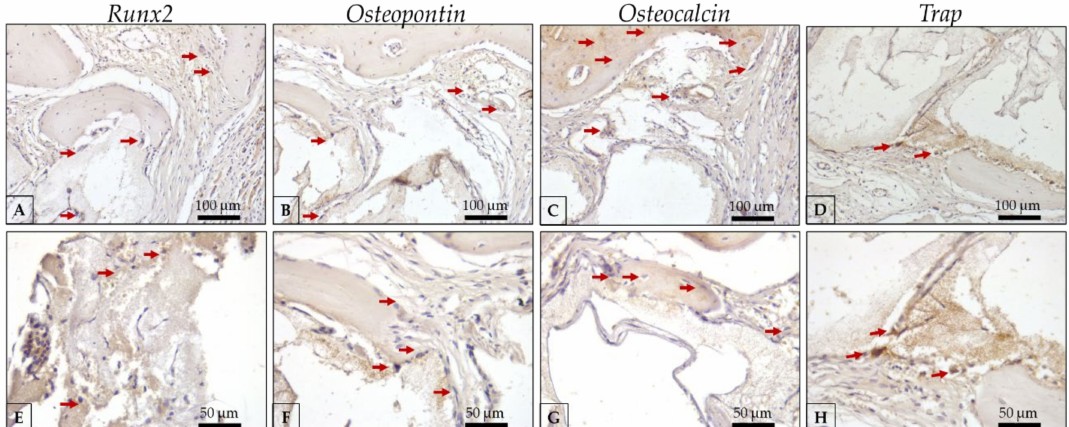
Figure 9. Representative photomicrographs of immunolabeling against Runx2, osteopontin, osteocal- cin, and Trap antibodies in the TCP/PG group at 30 days of critical defect repair. ( A ): Runx2 20 × magnification; ( B ): OPN 20 × magnification; ( C ): OCN 20 × magnification; ( D ): Trap 20 × magnifi- cation; ( E ): Runx2 40 × magnification; ( F ): OPN 40 × magnification; ( G ): OCN 40 × magnification; ( H ): Trap 40 × magnification; Counter-staining: Harris Hematoxylin; Red arrows: immunolabeling cells (represent positive labeling for each protein evaluated in the regions of interest). Scale bar: 100 µ m (20 × magnification) and, 50 µ m (40 × magnification).